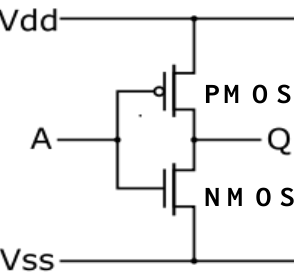
Figure 2. CMOSFETs, where input voltage is applied to A and output is extracted by the voltage of Q.